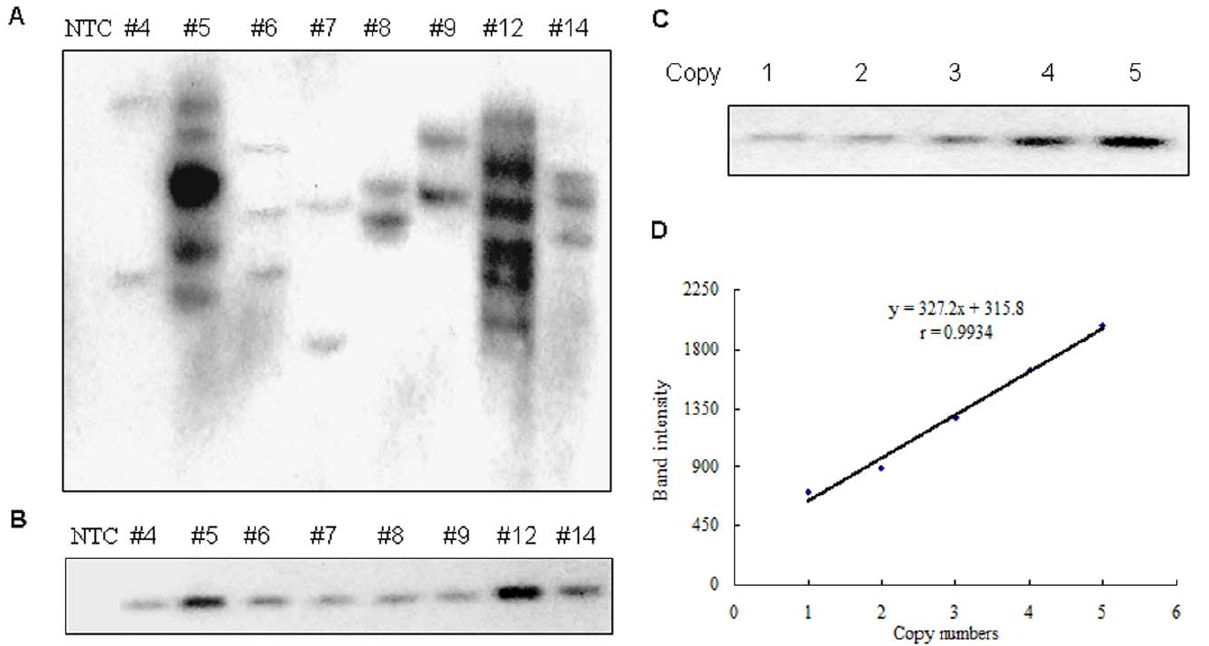
Figure 2. Southern blotting analysis of transgene integrants in genomic DNA of transgenic sheep. (A) Genomic DNA extracted from tail tips of transgenic sheep was digested with EcoRI and hybridized with 32 P labeled probe amplified from CMV promoter. (B) Genomic DNA extracted from tail tips of transgenic sheep was double-digested with Sfi I/ Hpa I and hybridized with 32 P labeled probe. NTC, non-transgenic sheep control; # 4– 14, transgenic lambs identified by PCR corresponding to Fig. 1A. (C) pLEX-EGFP plasmid was double-digested with Sfi I/ Hpa I and diluted in serial concentrations matched to corresponding copies. Diluted plasmids with copies from 1 to 5 were hybridized with probe double-digested genomic DNA of transgenic lamb in parallel. (D) Standard curve of copy numbers in panel C was generated with diluted plasmid based on the quantification of the blots by densitometric measurement as described in the Materials and Method.